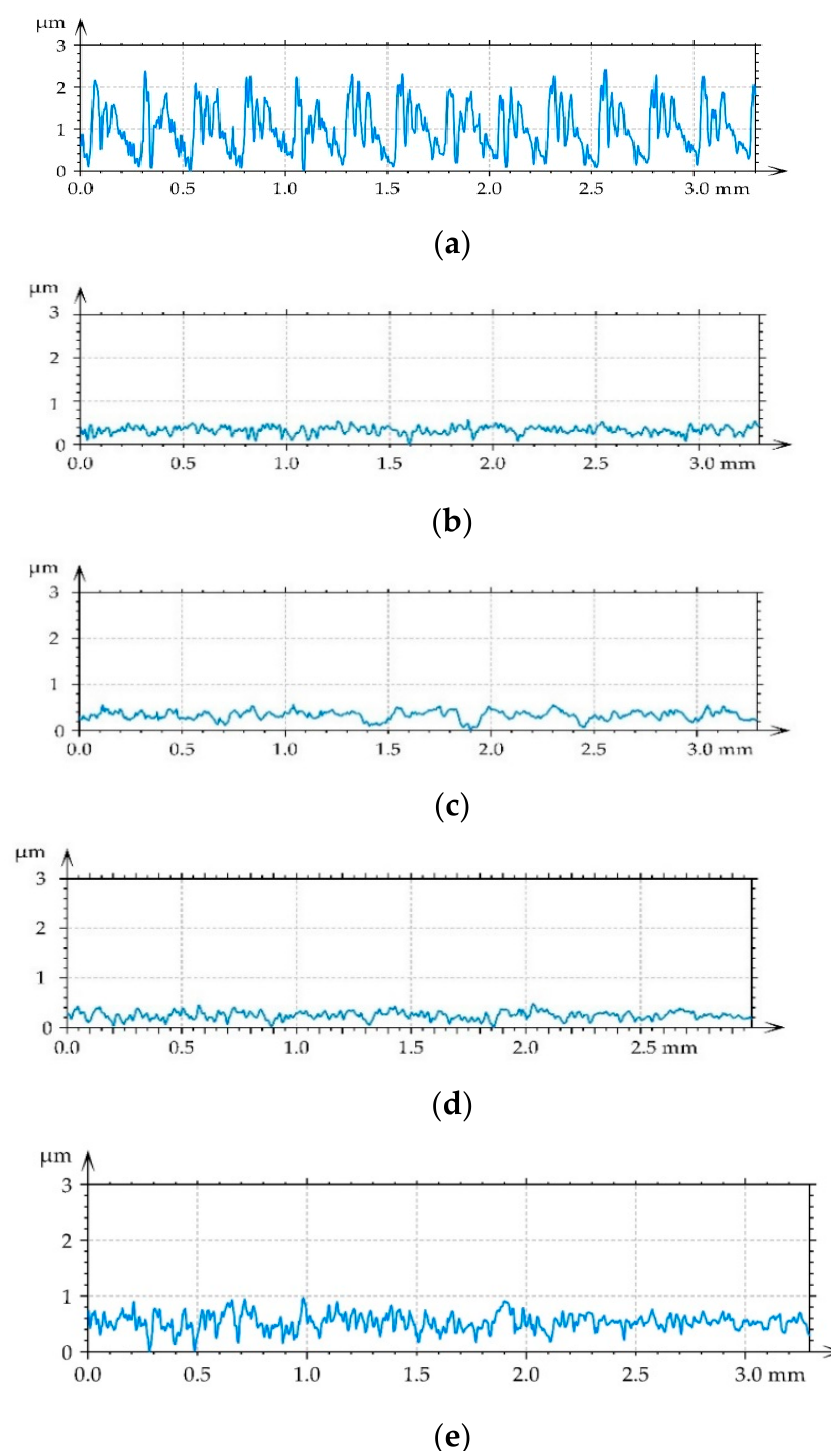
Figure 3. Representative roughness profiles of milled disc surface ( a ), and of burnished disc surfaces with pressures of 10 ( b ), 20 ( c ), 30 ( d ), and 40 MPa ( e ). One can see that ball burnishing caused decreases in height parameters: rms. height Sq, average height Sa, maximum height Sz, peak height Sp, valley depth Sv, and rms. slope Sdq. The decreases were the smallest for the highest pressure of 40 MPa. The correlation length Sal increased due to burnishing. The initial milled surface was one-directional anisotropic—the texture parameter Str was very small—0.014. As the results of